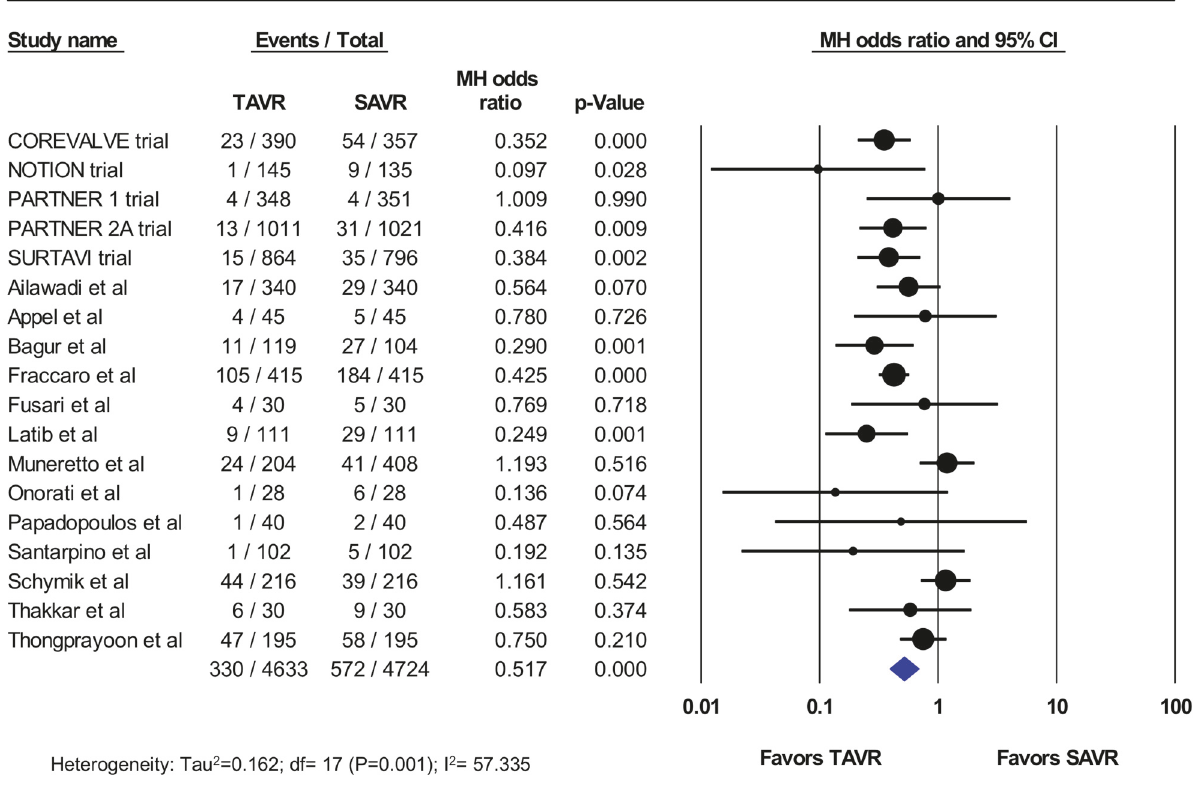
Figure 2: Pooled effect estimates for 30-day acute kidney injury according to the type of aortic valve replacement procedure. TAVR: transcatheter aortic valve replacement, SAVR: surgical aortic valve replacement.